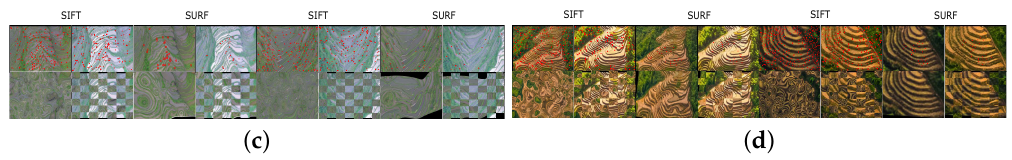
Figure 8. Agricultural terrace image registration examples on four typical image pairs. In ( a , b ), the first to the fourth rows are: the image pairs, transformed images and checkboards built by CPD (coherent point drift), GLMDTPS (global and local mixture distance with thin plate spline transformation), and ours, respectively. Yellow crosses denote 20 pairs landmarks. In ( c , d ), the first rows show the image pairs and the second rows show the transformed images and the checkboards built by SIFT (scale invariant feature transform) and SURF (speeded-up robust features), respectively. Red circles denote the extracted feature